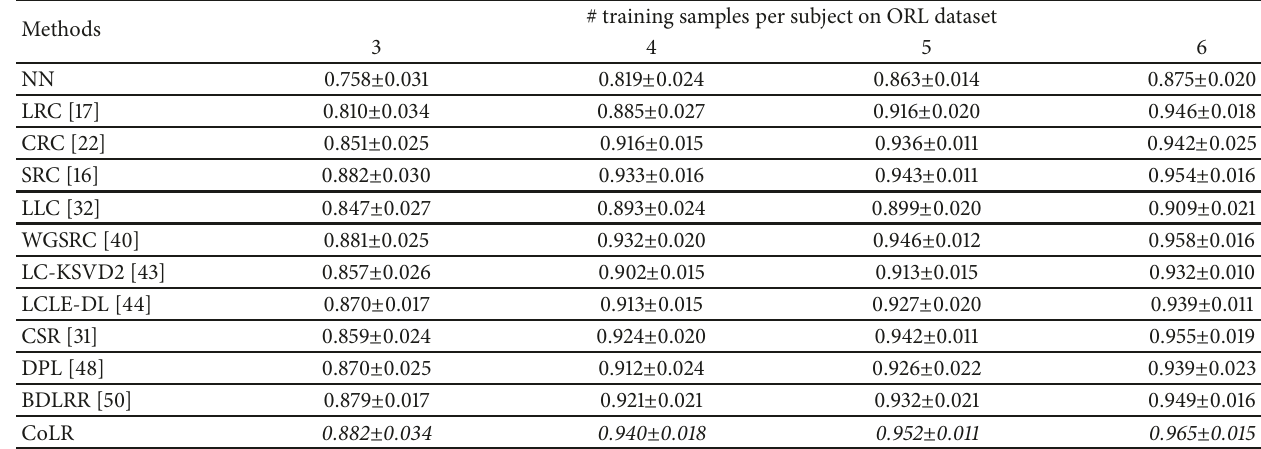
Table 3: Recognition rates on the ORL dataset with different number of training samples.